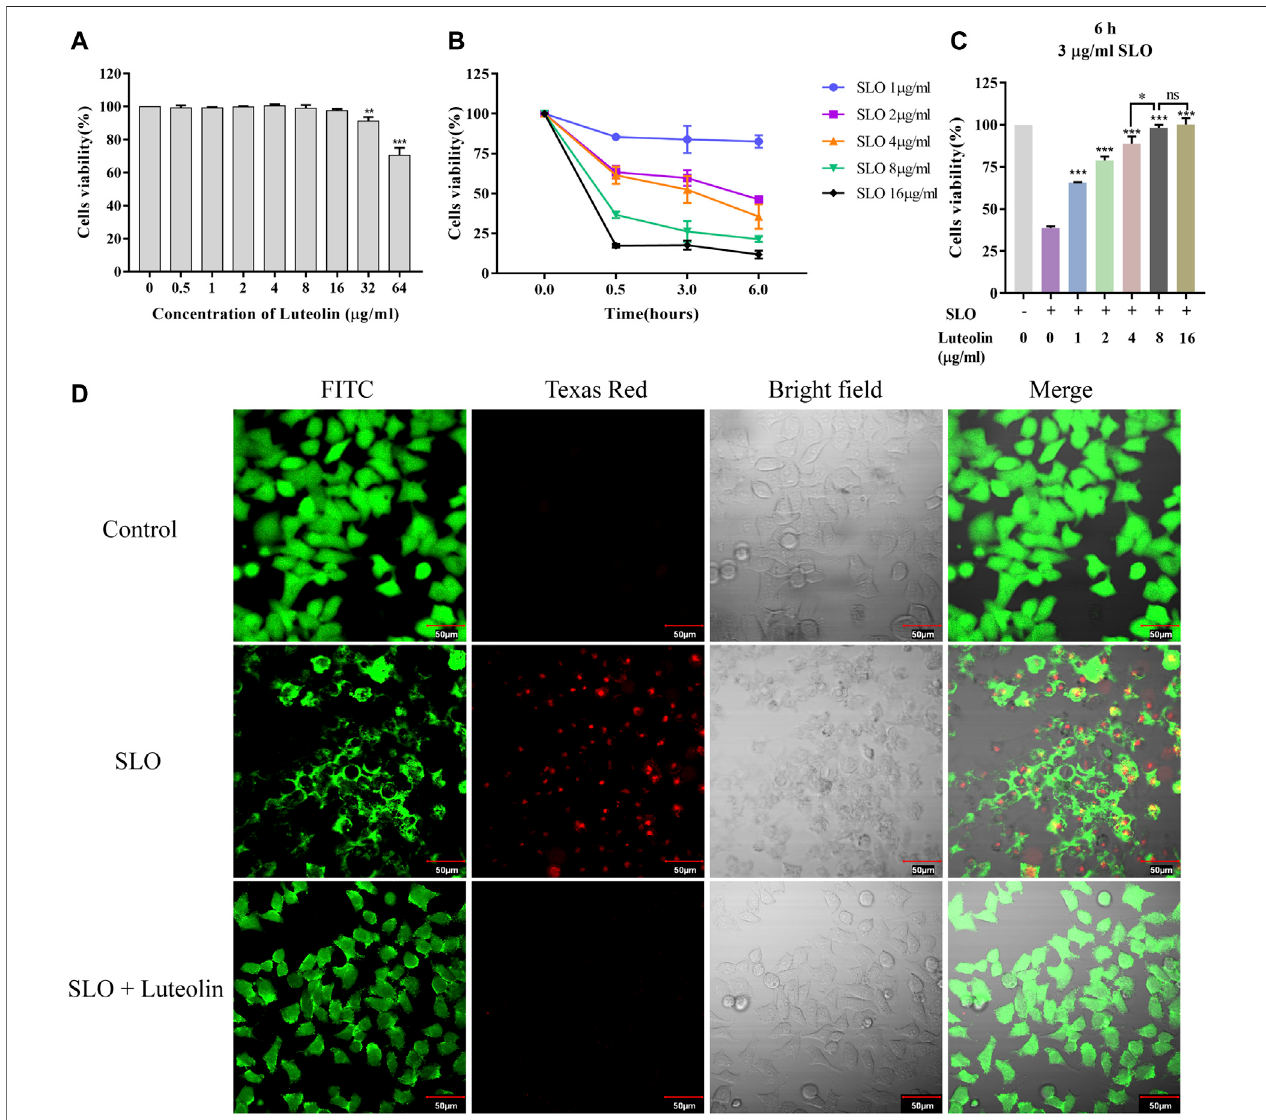
FIGURE 5 | Effect of Luteolin on SLO toxin-mediated pathology in human HEp-2 cells. (A) Cytotoxicity of luteolin for 24 h. (B) Dose-response and time-course experimentstoevaluateSLOcytotoxiceffectsinHEp-2cells.CellsweretreatedwithSLOatconcentrationsof1,2,4,8,and16 μ g/mlfor0,0.5,3,and6 h,respectively. Cell viability was determined by the CCK-8 assay, and the cell viability of the untreated group was de fi ned as 100%. Data represent the mean value ± SD derived from three replicates. (C) HEp-2 cells were treated for 6 h with 3 μ g/ml of SLO, in the absence or presence of luteolin. The cell viability was determined by the CCK-8 assay, and the cell viability of the untreated group was de fi ned as 100%. Data represent the mean value ± SD derived from three replicates (Two-way ANOVA and Tukey ’ s post test). * p < 0.05; ** p < 0.01; *** p < 0.001, with ns. used to indicate results were not signi fi cant. (D) HEp-2 cells were treated with 3 μ g/ml of SLO, in the absenceorpresenceofluteolin(8 μ g/ml),for6 h.CellswerestainedwithFITC fl uorescentcelldyesolution(greensignal)tovisualizelivingcells.TexasRedstaining,which mainly produces nuclear red fl uorescence in cells with damaged cell membranes, was used to visualize damaged